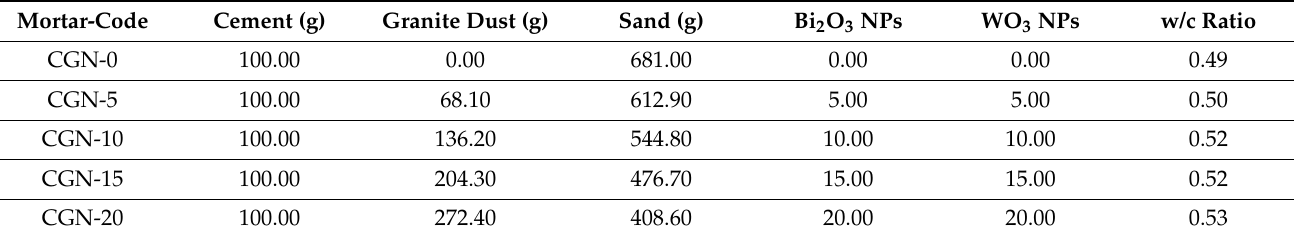
Table 1. Mass composition of the prepared mortars.